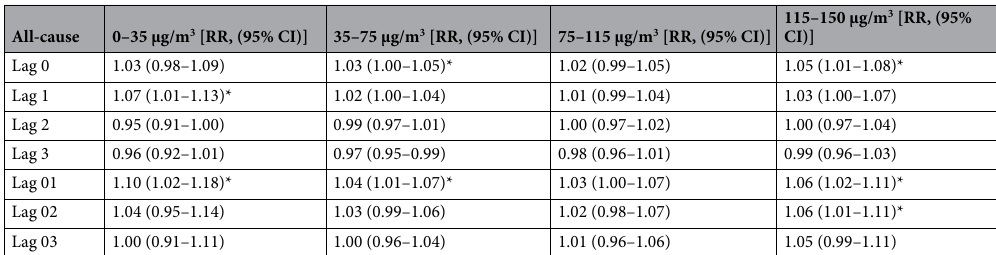
Table 3. Relative risk (RR) with 95% confidence interval (CI) for daily All-cause mortality from exposure to different PM 2.5 ranges in Jinan, China, from 2013 to 2015, both sexes, all ages. *p <